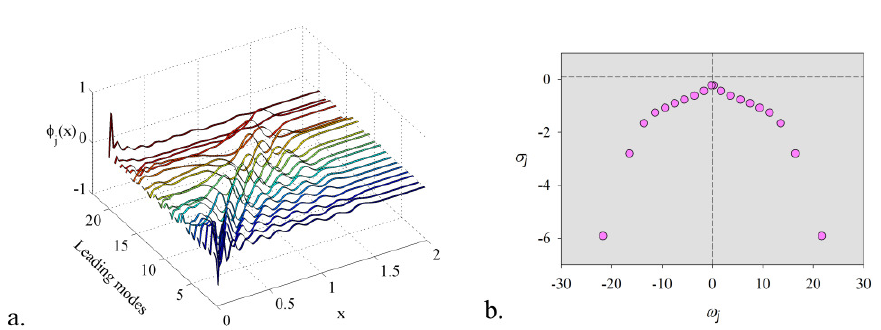
Figure 9. The case Re = 10 4 : ( a ) The DMD leading modes, ( b ) Growth rates and associated frequencies ( σ , ω ) of the eigenvectors of the Koopman matrix S .